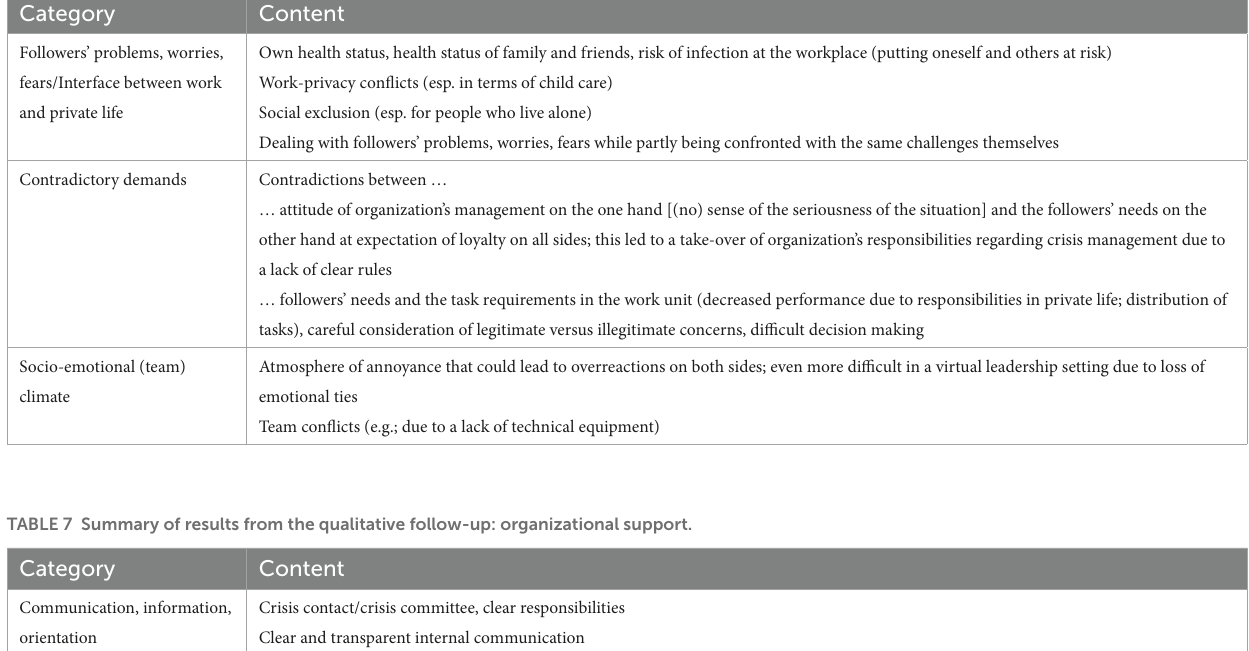
TABLE 6 Summary of results from the qualitative follow-up: emotional demands.